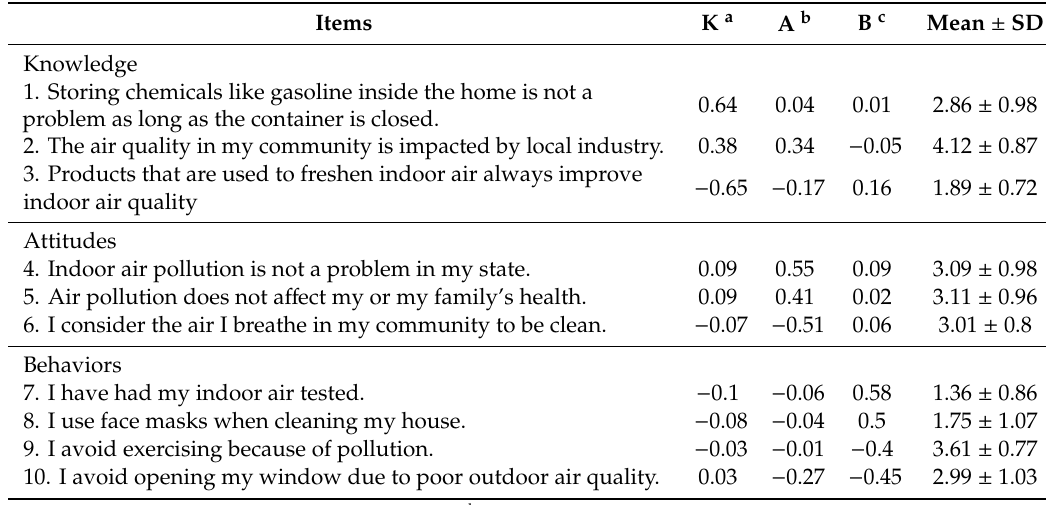
Table 2. Exploratory factor analysis results for the Air